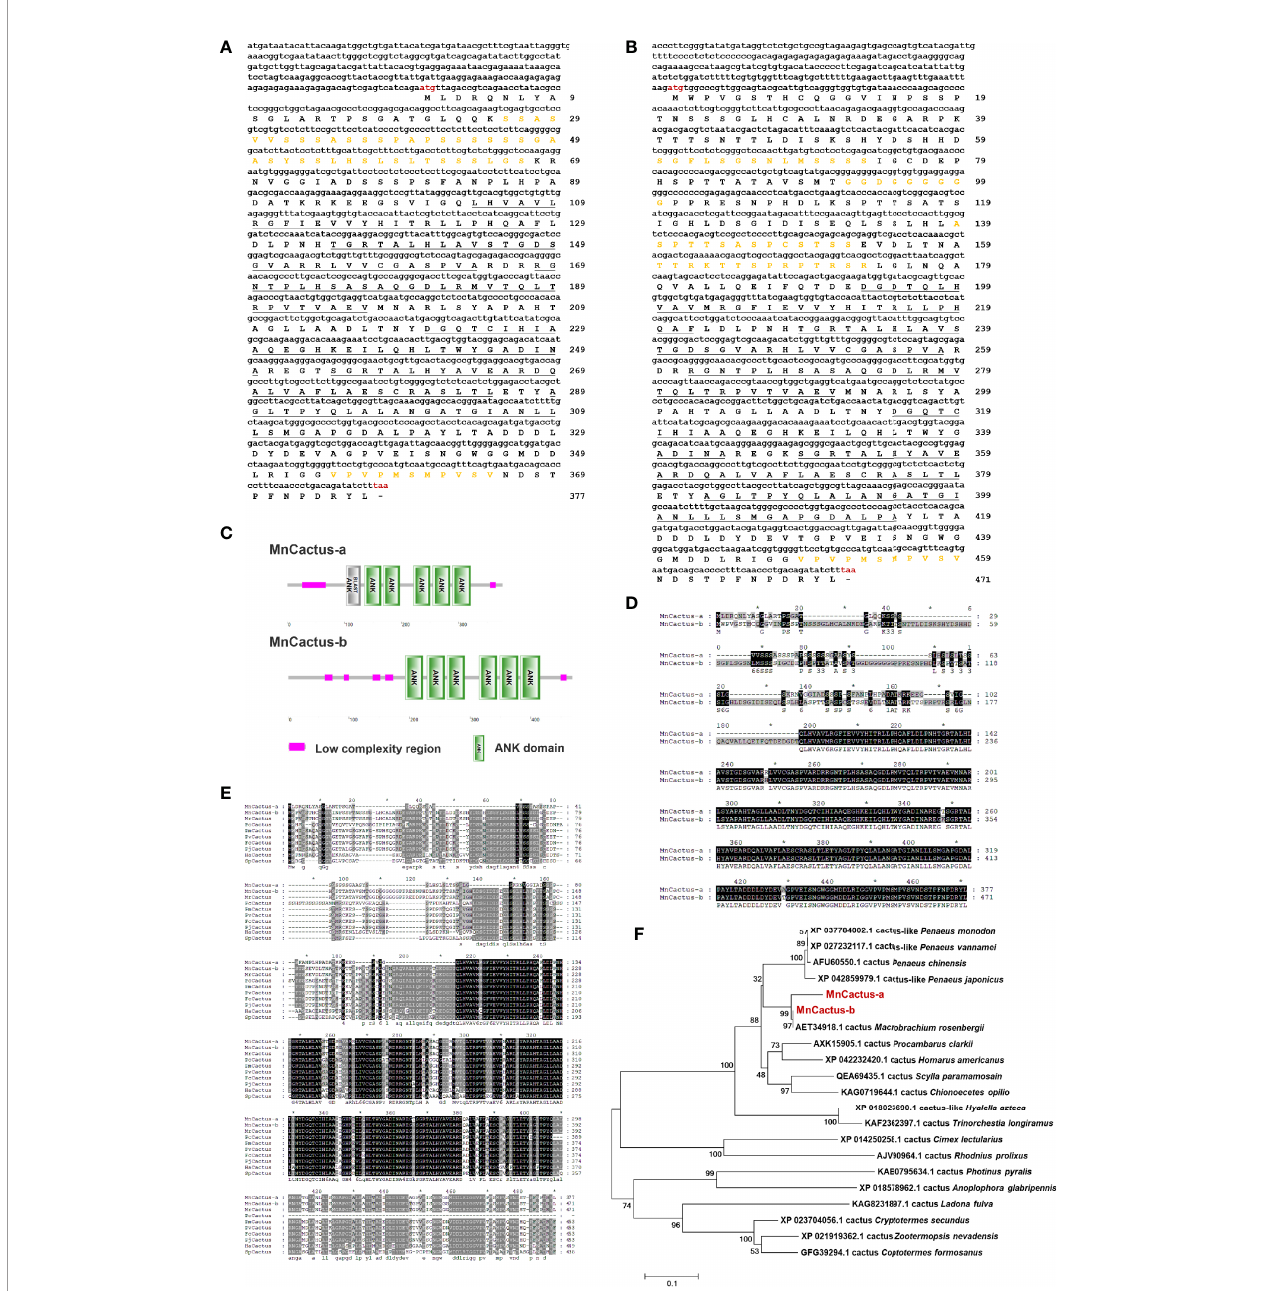
FIGURE 2 | Nucleotide and deduced amino acid sequences of MnCactus-a (A) and MnCactus-b (B) from M. nipponense. The sequences were shown and numbered along the right margin. The red letters indicated the start codon (ATG) and the stop codon (TAA). The ANK domains were underlined, and the low complexity regions were marked in orange. (C) Domain organizations of MnCactus-a and MnCactus-b predicted by SMART. (D) The sequence alignment of MnCactus-a and MnCactus-b. (E) Multiple sequence alignment of MnCactus with other Cactus sequences. The identical amino acid residues were shaded in black and the similar residues in gray. The species and the GenBank accession numbers were as follows: MrCactus from M. rosenbergii (AET34918.1); PcCactus from P. clarkii (AXK15905.1); PmCactus from P. monodon (XP_037784002.1); PvCactus from P. vannamei (XP_027232117.1); FcCactus from P. chinensis (AFU60550.1); PjCactus from P. japonicus (XP_042859979.1); HaCactus from H. americanus (XP_042232420.1); SpCactus from S. paramamosain (QEA69435.1). (F) NJ phylogenetic tree analysis of the amino acid sequences of 21 Cactus from different species. Bootstrap resampling (1000 pseudo-replicates) was used to test the reliability of the branching. MnCactus-a and MnCactus-b were marked in